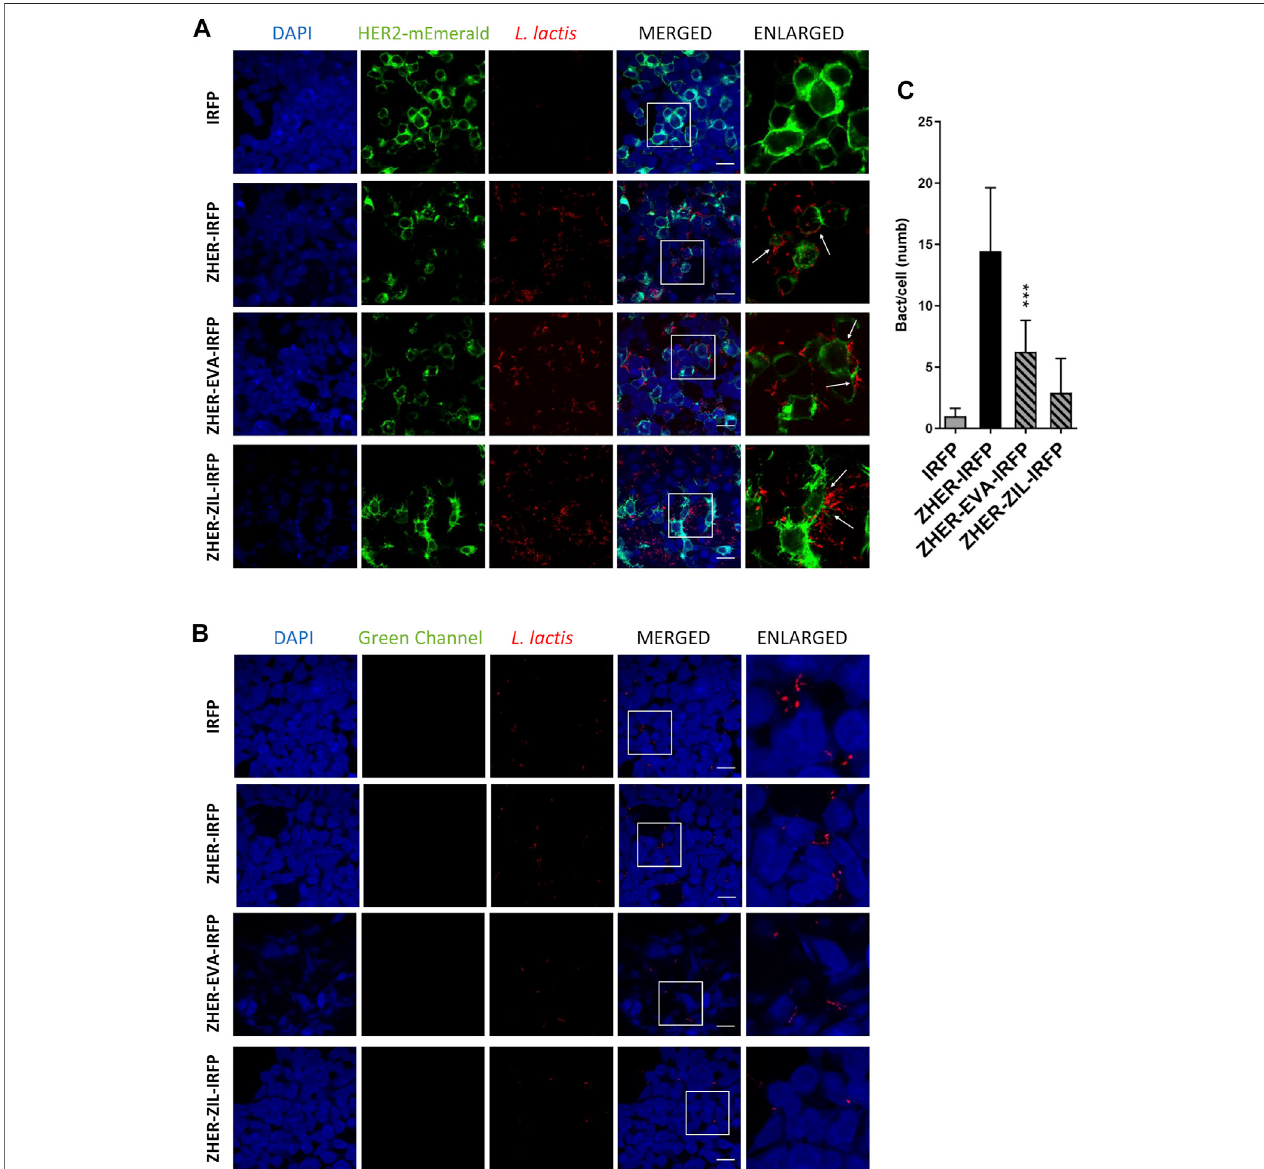
FIGURE 8 | The engineered L. lactis speci fi cally adhere to HER2-overexpressing HEK293 cells. Representative confocal microscopy images ofadhesion ofZHER co-expressing L.lactis toHEK293cellstransfectedwithHER2 (A) ortonontransfectedHEK293cells (B) .Imageswerequanti fi edbydeterminingthenumberofadhered bacteria per HEK293 cell in 10 representative micrographs for each experimental condition, using ImageJ (C) . L. lactis strains tested: L. lactis -ZHER-EVA-IRFP ( L. lactis co-expressing ZHER, EVA, and IRFP); L. lactis -ZHER-ZIL-IRFP ( L. lactis co-expressing ZHER, ZIL, and IRFP); L. lactis -ZHER-IRFP ( L. lactis co-expressing ZHER and IRFP; positive control); and L. lactis -IRFP ( L. lactis expressing only IRFP; negative control). DAPI, DAPI channel showing HEK293 cell nuclei; HEK293-HER2- mEmerald, green fl uorescence channel showing mEmerald-labeled HER2 overexpressed on the surfaces of the HEK293 cells; L. lactis , red fl uorescence channel showing L. lactis . Enlarged images show attachment of L. lactis to transfected HEK293 with characteristic adhesion pattern (arrows). White squares indicate enlarged sections of the images. Scale bars, 20 μ